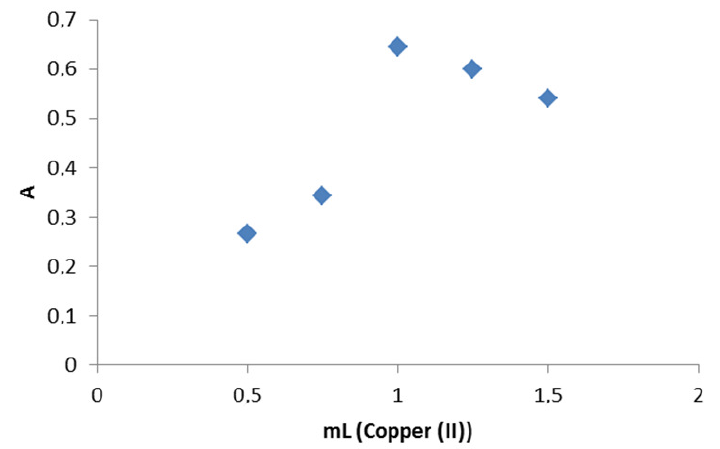
Figure 5. Effect of volume of copper(II) (0.5%, w/v) on the development of the complex of MPT (20 µ g/mL) with